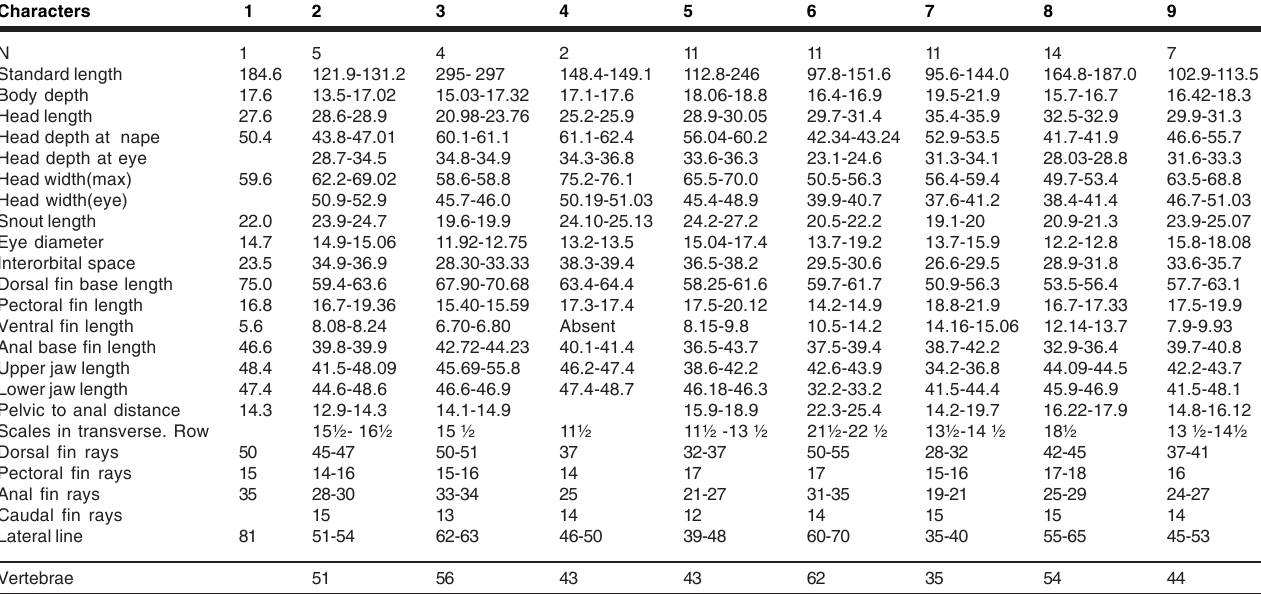
Table 1. Morphological characters of Channa species (% SL, except SL in mm) under